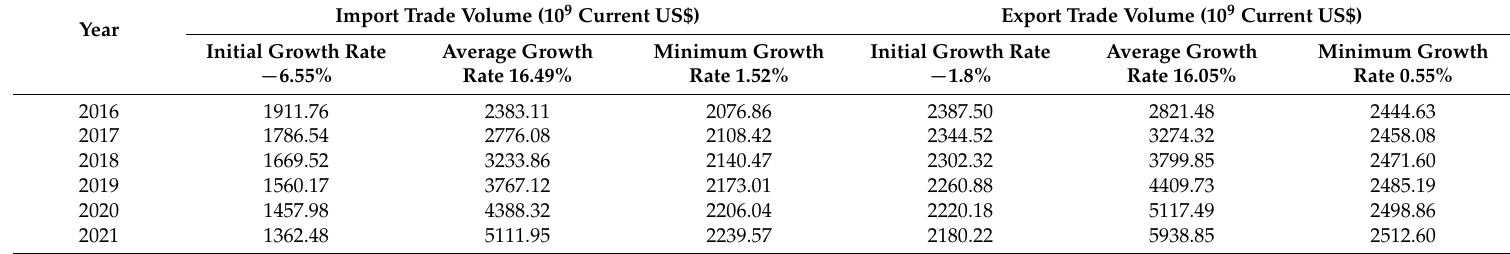
Table 5. China’s import and export estimation